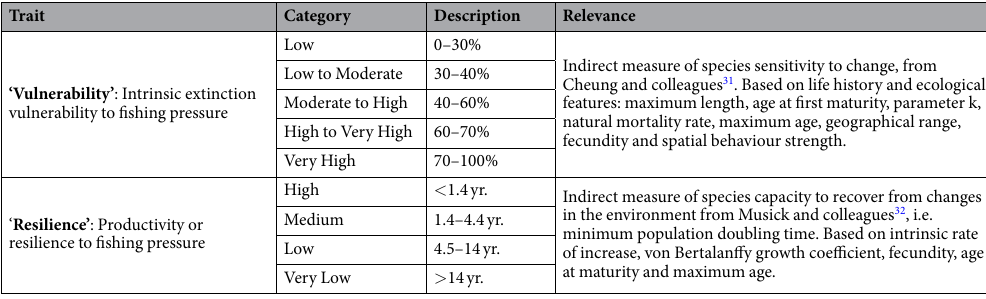
Table 1. Description and relevance of fish